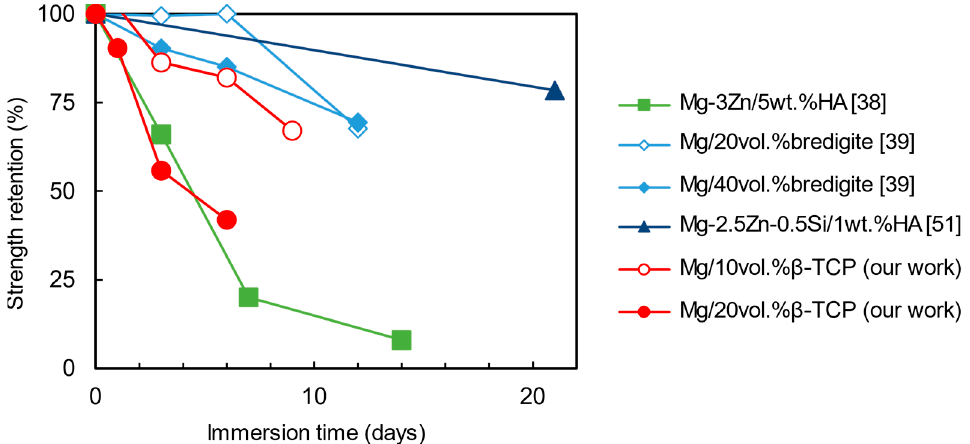
Figure 11. Strength retention of Mg-based composites before and after degradation.